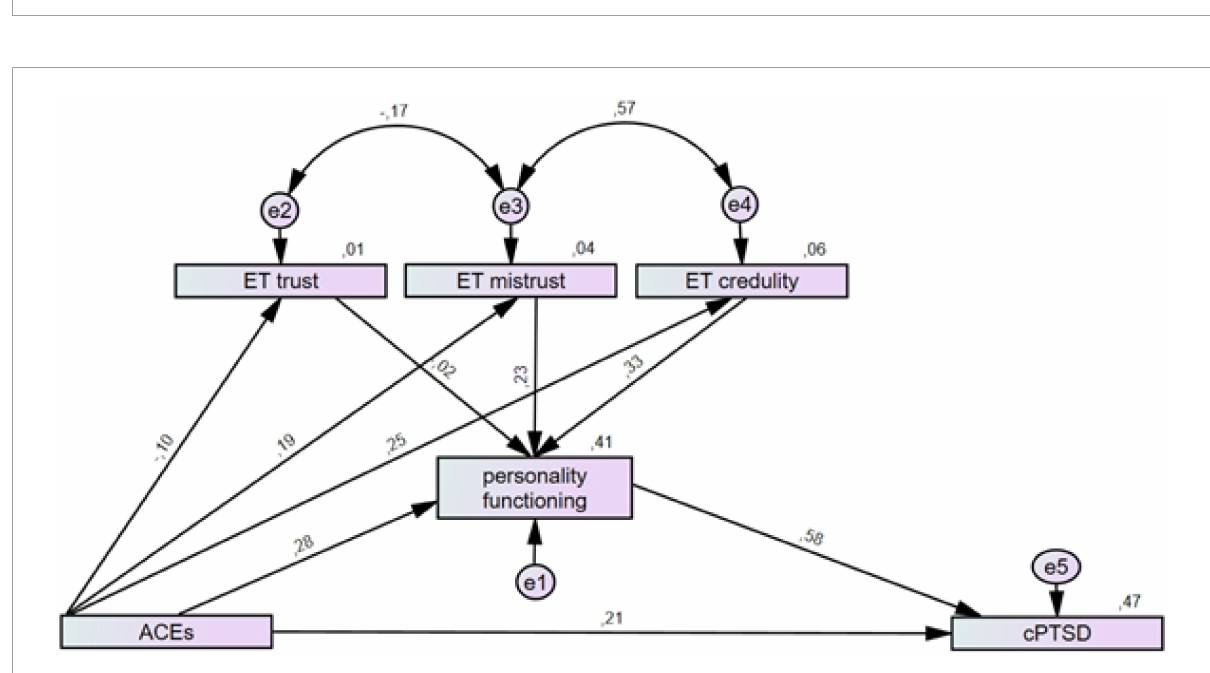
FIGURE3 Structural equation models for the mediation effect of personality functioning and epistemic trust on the relationship of ACEs with cPTSD symptoms. Personality functioning was added as mediator for the association between ACEs and cPTSD and the three epistemic trust subscales as predictors of personality functioning. Rectangles represent variables (ACEs, Adverse Childhood Experiences measured by the ACE; personality functioning measured by the OPD-SQS; ET, epistemic trust measured by the ETMCQ; cPTSD, complex posttraumatic stress disorder symptoms measured by the ITQ) and circles represent error terms (e). Numbers next to arrows in the model represent standardized estimates, numbers next to factors represent the R2, i.e. the explained